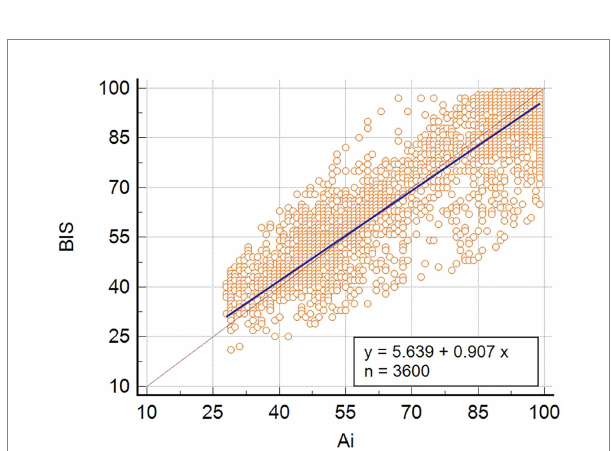
FIGURE 2 Deming regression analysis of Ai and BIS. The valve of BIS ranged from 21 to 98, and the value of Ai ranged from 29 to 99.